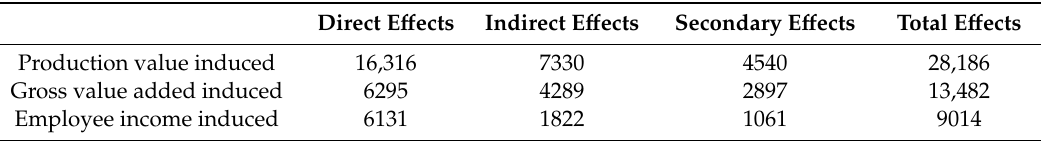
Table 9. The economic impact of constructing a concrete check dam (after unifying the amount of sediment runo ff prevention; unit is thousand